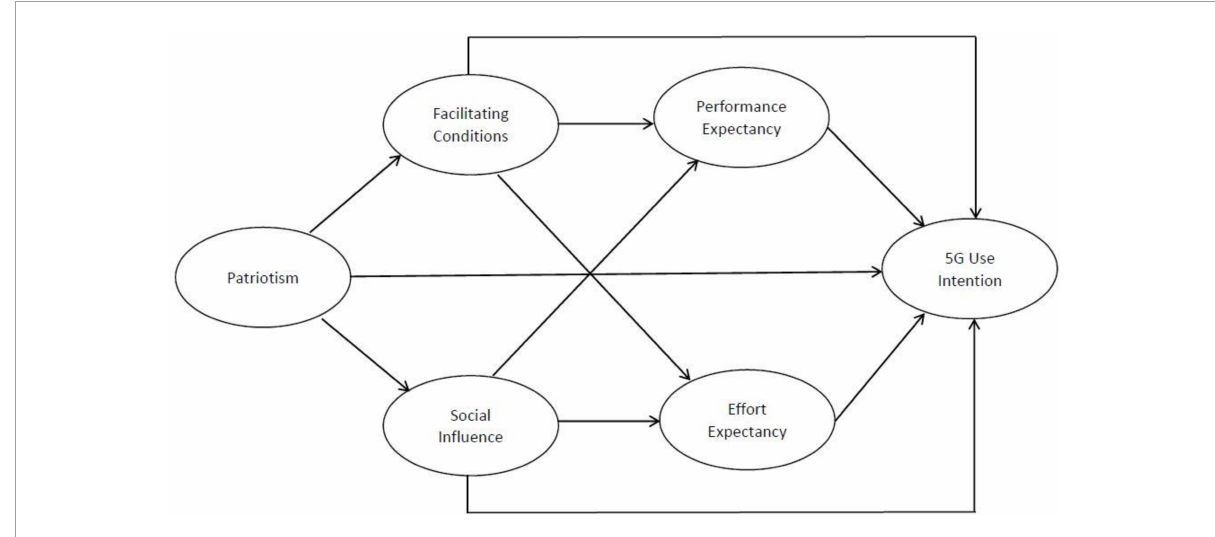
FIGURE1 Conceptual model of Chinese 5G use